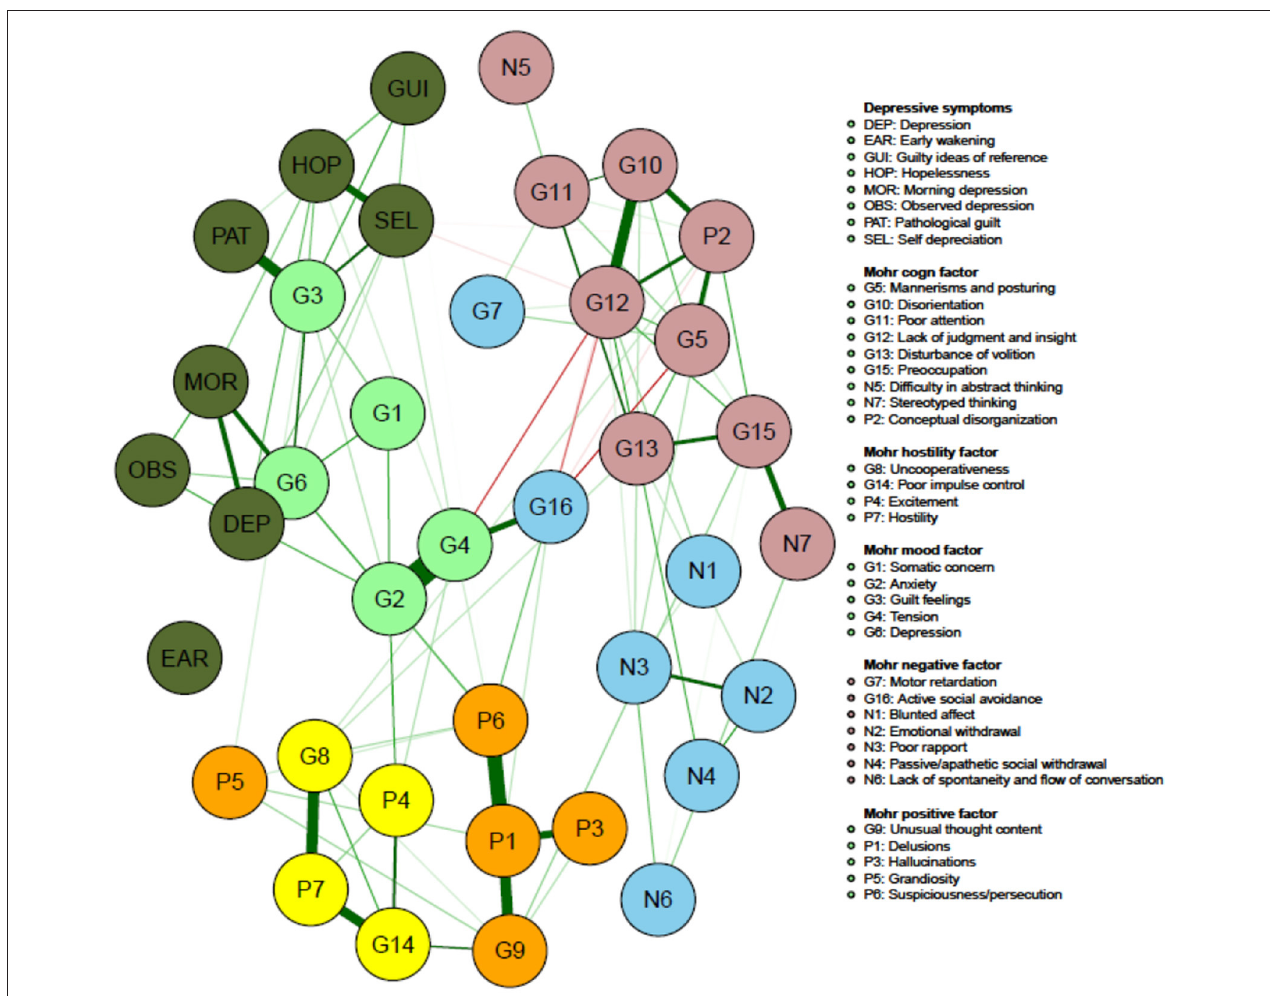
FIGURE 2 | Network of PANSS symptoms and CDSS symptoms in patients with persistent and predominant negative symptoms (colors illustrating the Mohr 5-factor model of the PANSS; orange, positive symptom factor; yellow, hostility factor; blue, negative symptom factor; pink, cognitive symptom factor; pale green mood factor; dark green, CDSS